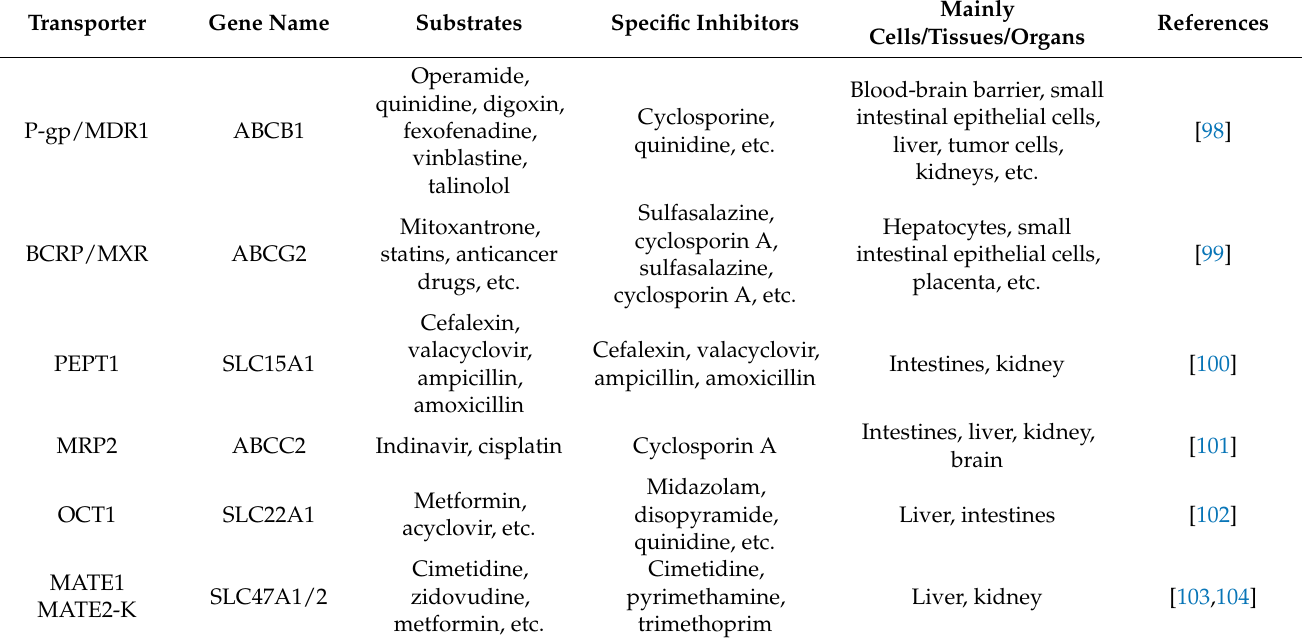
Table 4. Substrates, inhibitors and distributions of several common